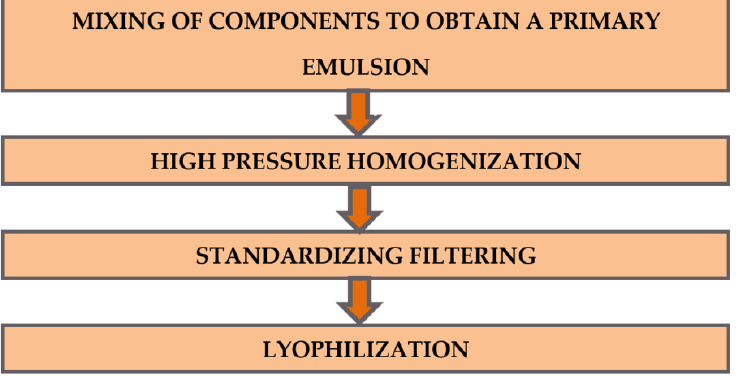
Figure 1. The scheme of obtaining the composition of